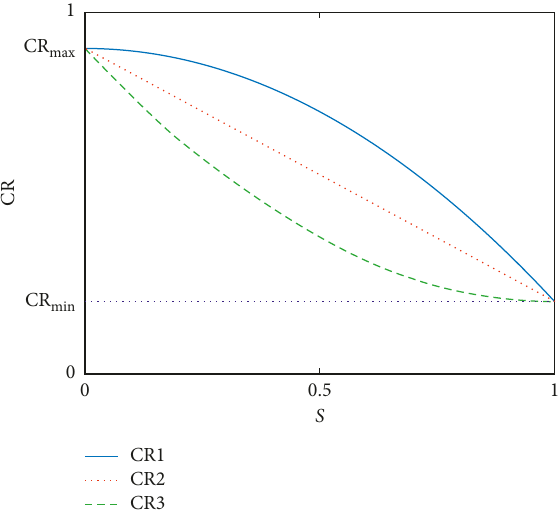
Figure 3: Changing curves of crossover probability. CR1 is the part of a convex quadratic curve, CR2 is the part of a linear curve, and CR3 is the part of a concave quadratic